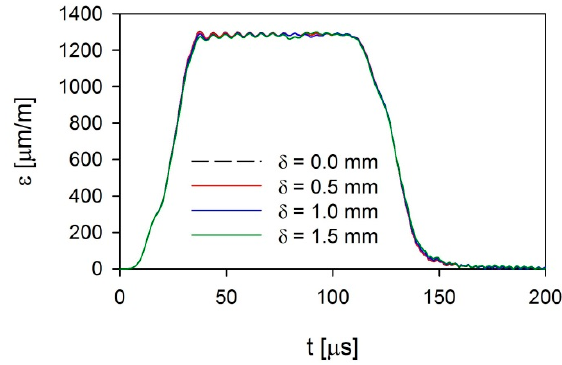
Figure 8. Incident-disturbed pulses for SHPB using a pulse shaper for an imperfection in the form of neutral axis offset δ .